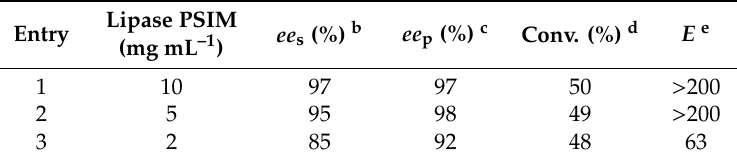
Table 3. E ff ect of enzyme concentration in the hydrolysis of ( ± )-3 a a